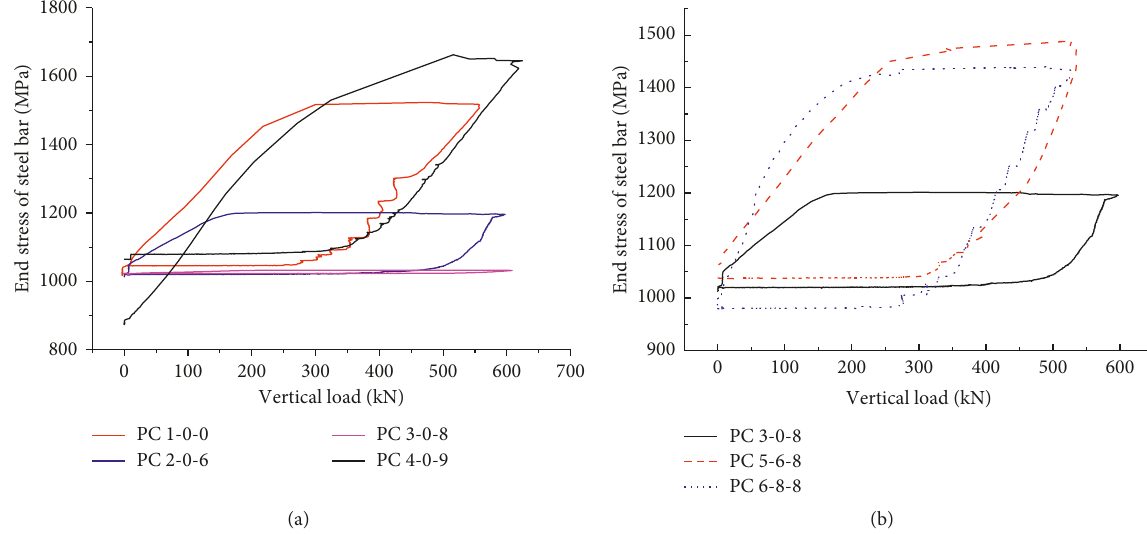
Figure 12: Stress changes under load in RBPC tendons (both ends). (a) Effect of different degrees of curing of retard-bonding agent on load- carrying capacity. (b) Effect of different tensile periods on load-carrying